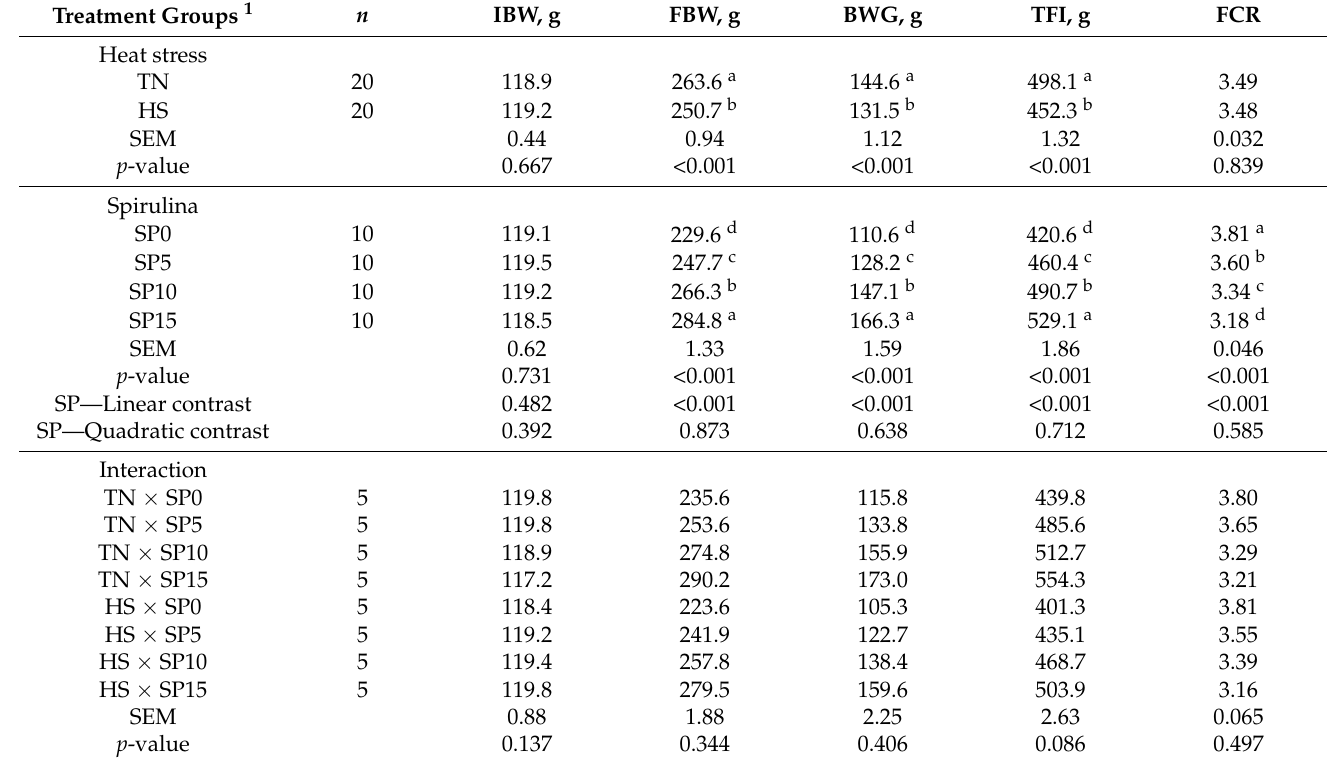
Table 3. Heat stress, spirulina, and their interaction effects on the production performance of Japanese quail